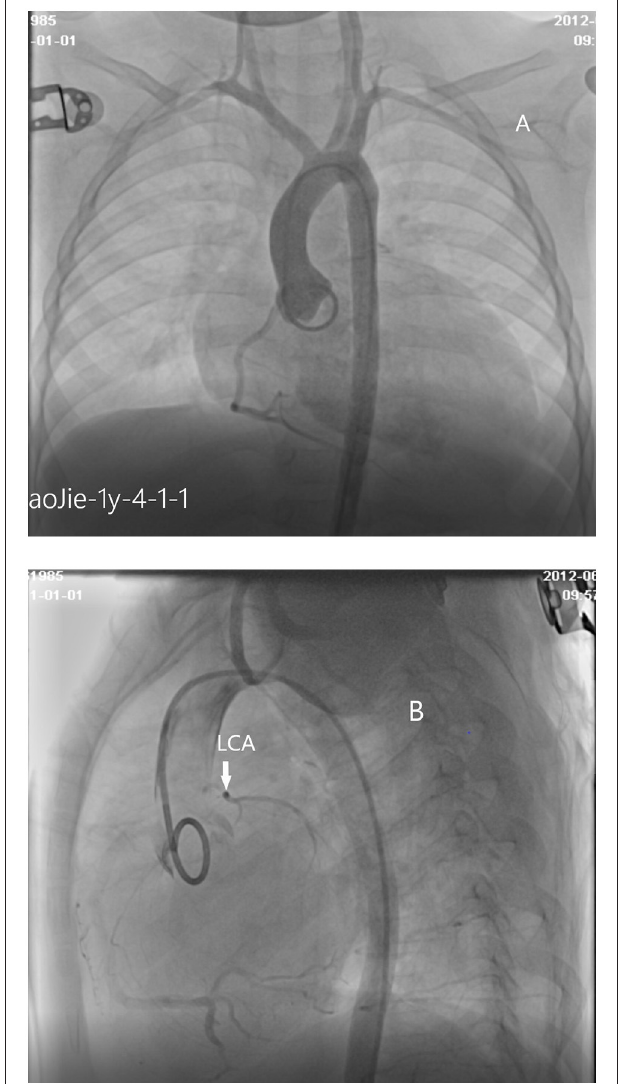
FIGURE 5 | (A) Cardiac angiography: No left coronary artery opening is found in the left coronary sinus by aortography. (B) Cardiac angiography:atresia of left coronary ostium and hypoplasia of main stem of left coronary